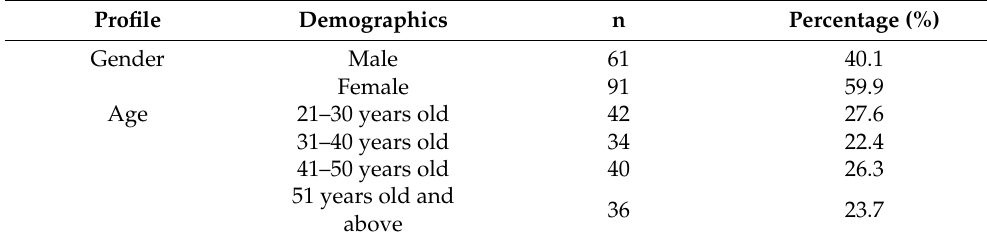
Table 1. Respondents demographic